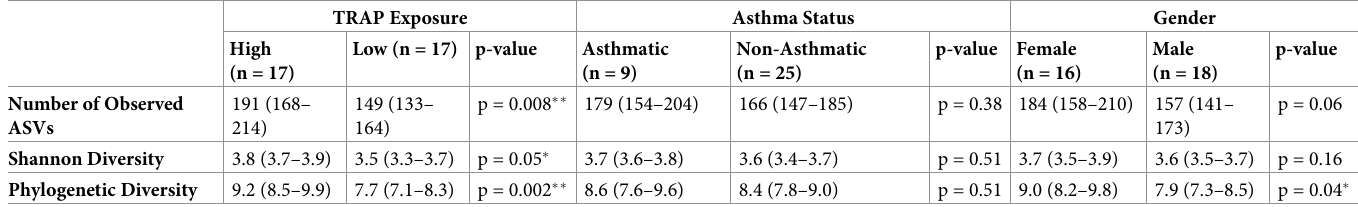
Table 1. Mean (95% confidence interval) and p-value for each bacterial alpha diversity measure in the sputum by TRAP exposure, asthma status, and gender. TRAP Exposure Asthma Status Gender High Low (n = 17) p-value Asthmatic Non-Asthmatic p-value Female Male p-value (n = 17) (n = 9) (n = 25) (n = 16) (n = 18) Number of Observed